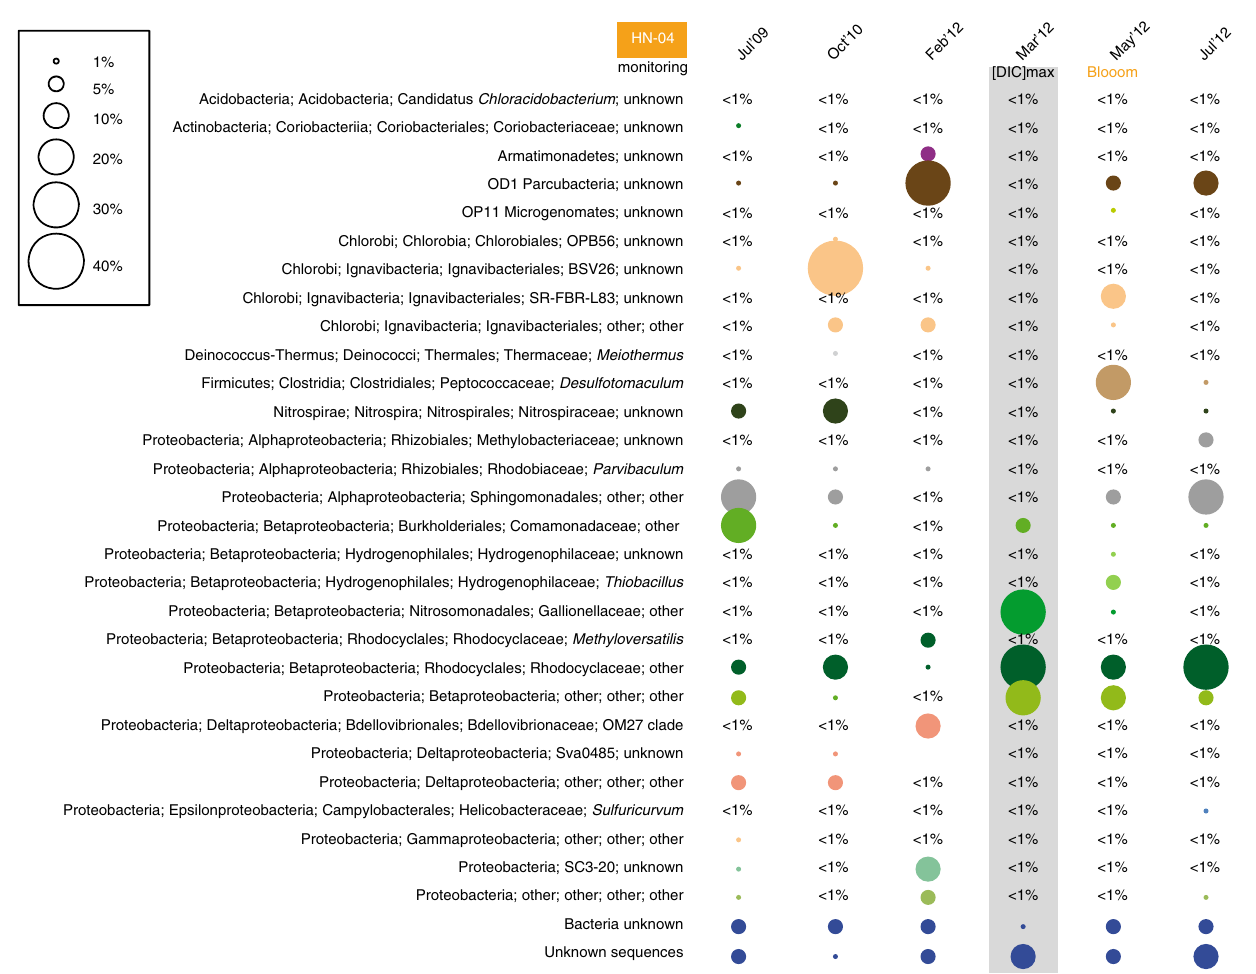
Fig. 3 Relative abundance of OTUs retrieved by 454-pyrosequencing of the 16S-rRNA genes in HN-04 groundwater for the six sampling periods. OTUs are de fi ned at a sequence similarity ≥ 97%. OTUs retrieved at less than 1% during any time period are not represented. For each OTU, the size of the circle represents the exact percentage of its abundance. In the size scale, some reference points are given for abundances ranging from 1 to 40%. The gray box indicates the sampling period displaying the highest DIC concentration for well HN-04